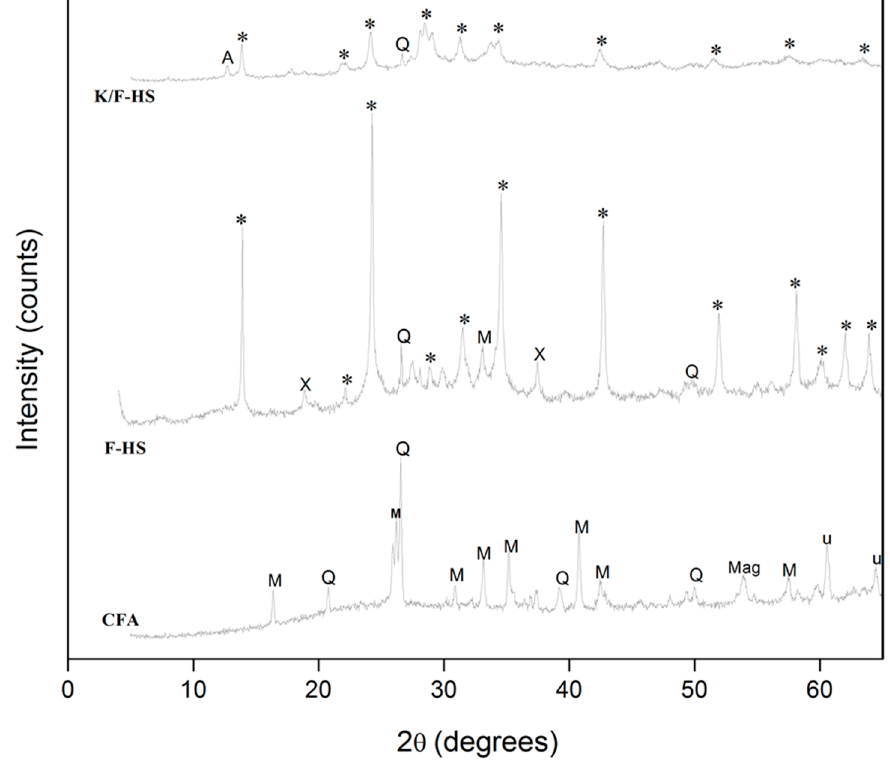
Figure 1. XRD patterns of CFA, F-HS and K/F-HS (*—hydroxy sodalite, x—zeolite X, A—zeolite A, M—mullite, Q—quartz, Mag—magnetite).